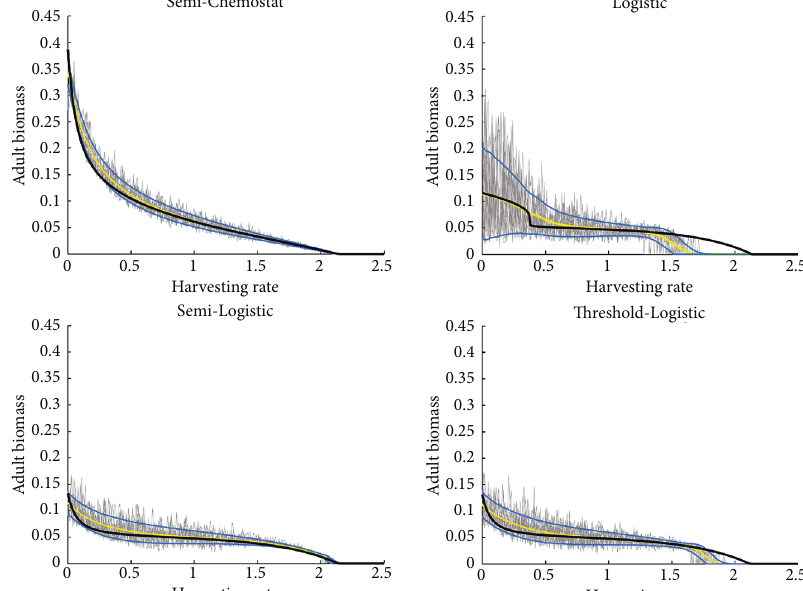
Figure 17: Adult biomass of semichemostat, logistic, semilogistic. and threshold-logistic growth rate at steady state w.r.t. harvesting rate. The grey trajectories show the adult biomass from di ff erent simulations for the stochastic case. The yellow curve represents the adult biomass mean value of the simulations. The light blue curves represent the interval of standard deviation (68%) of adult biomass. The black curve represents the adult biomass for the deterministic